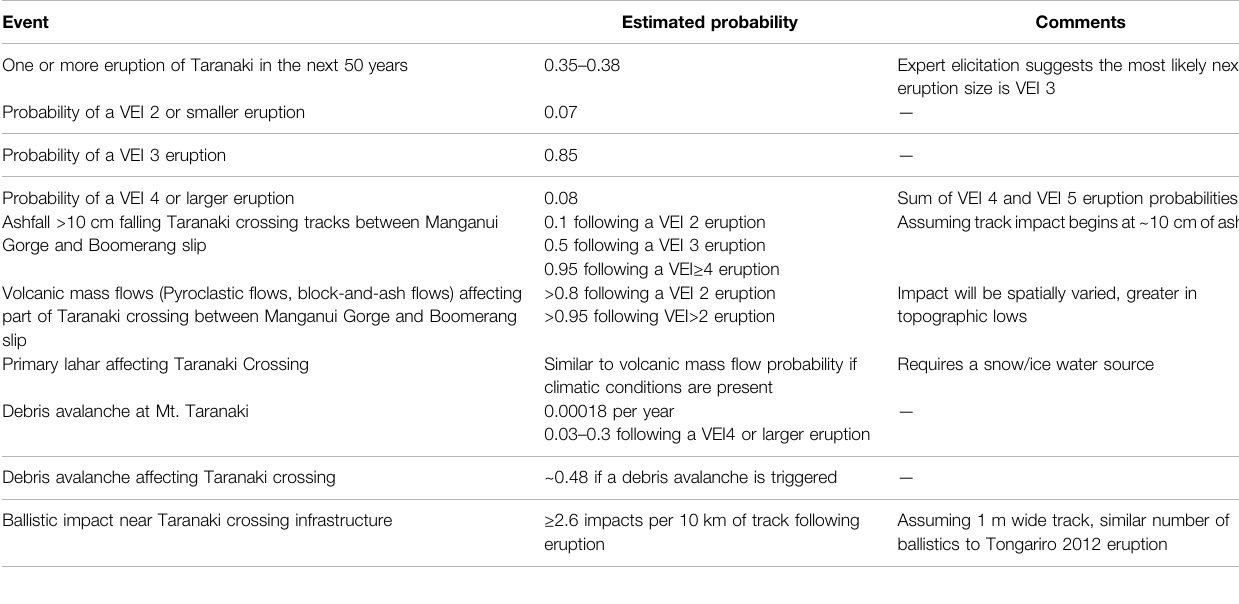
TABLE 3 | Summary of estimated probabilities affecting Taranaki Crossing project tracks.